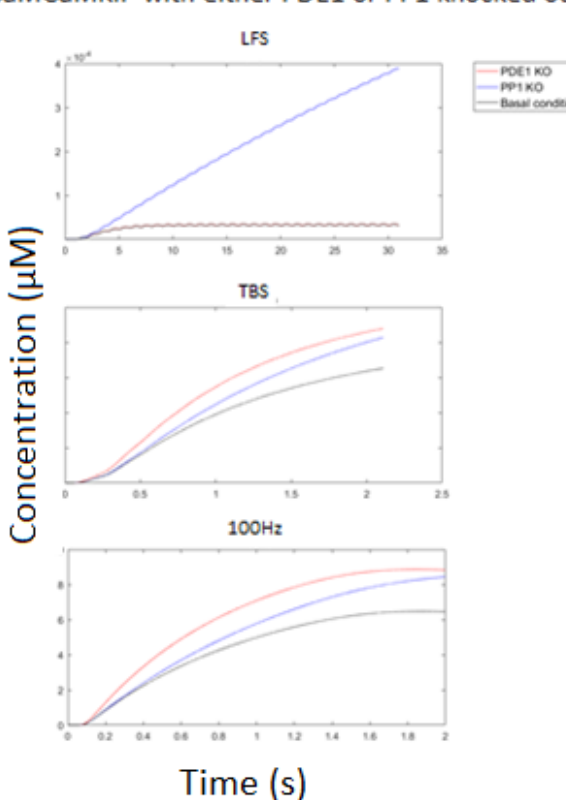
Figure 11. Concentration of phosphorylated CaMKII (pT286 ‐ CaMKII ‐ CaM) at LFS, 10 Hz, TBS, and 100 Hz (from left to right) at standard conditions (black line); with no PP1 activity (PP1 KO) (blue line); PDE1 knocked out of the system (PDE1 KO) (red line). Each stimulation was run for the entirety of the stimulation then 1 s post ‐ stimulation. Notice how pT286 ‐ CaMKII ‐ CaM accumulated